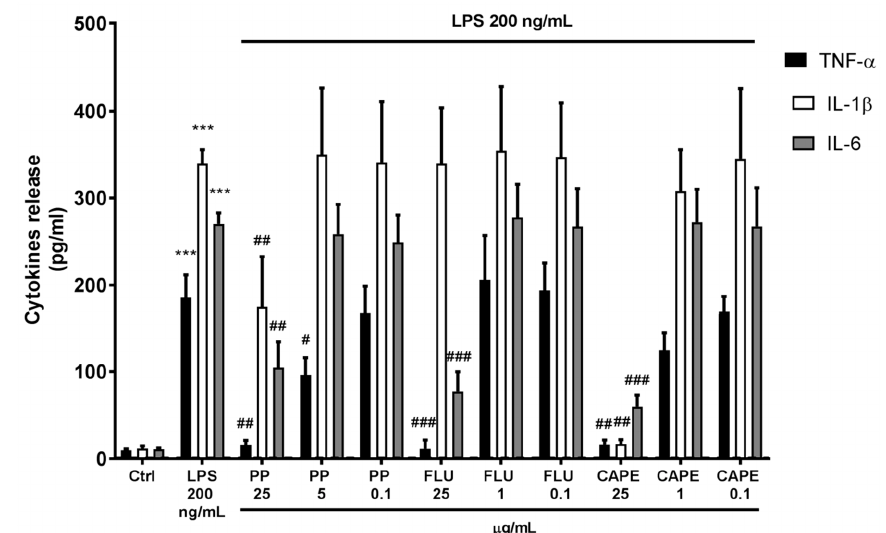
Figure 2. Effects of poplar propolis (PP), flurbiprofen (FLU), and CAPE on cytokine release by LPS-stimulated human PBMC. *** p < 0.05 vs. Ctrl; # p < 0.05 vs. LPS ## p < 0.01 vs. LPS; ### p < 0.001 vs. LPS